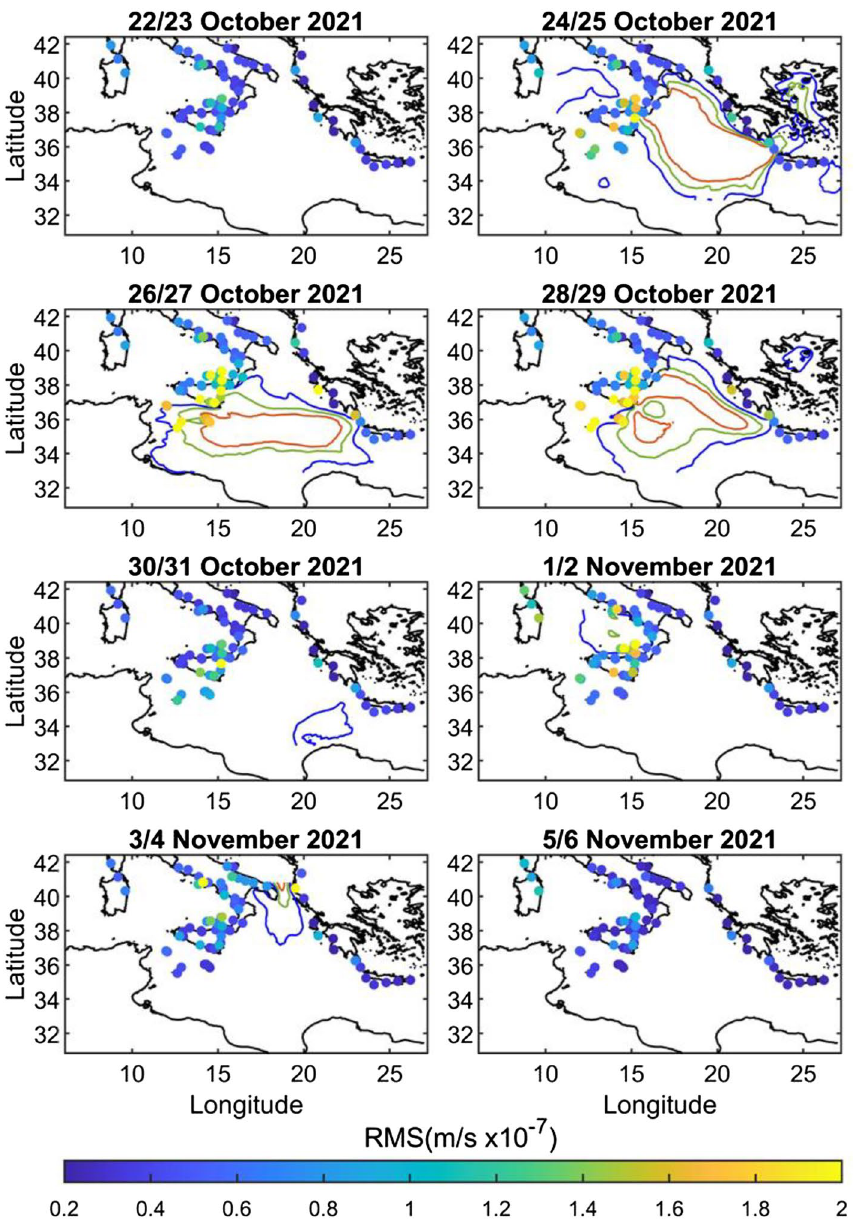
Figure 3. Spatial and temporal distribution of the RMS amplitude for the SM band. Each dot represents a station while the colors represent the RMS amplitude as specified in the color bar. The blue, green and orange contours line represent respectively significant wave heights of 2, 2.5 and 3 m obtained from the Copernicus product